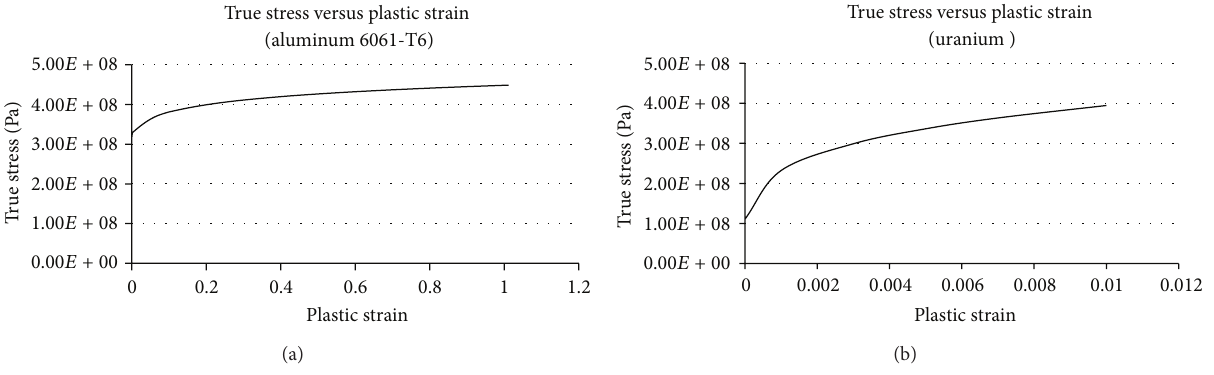
Figure 4: True stress and plastic strain data for aluminum 6061-T6 and uranium.